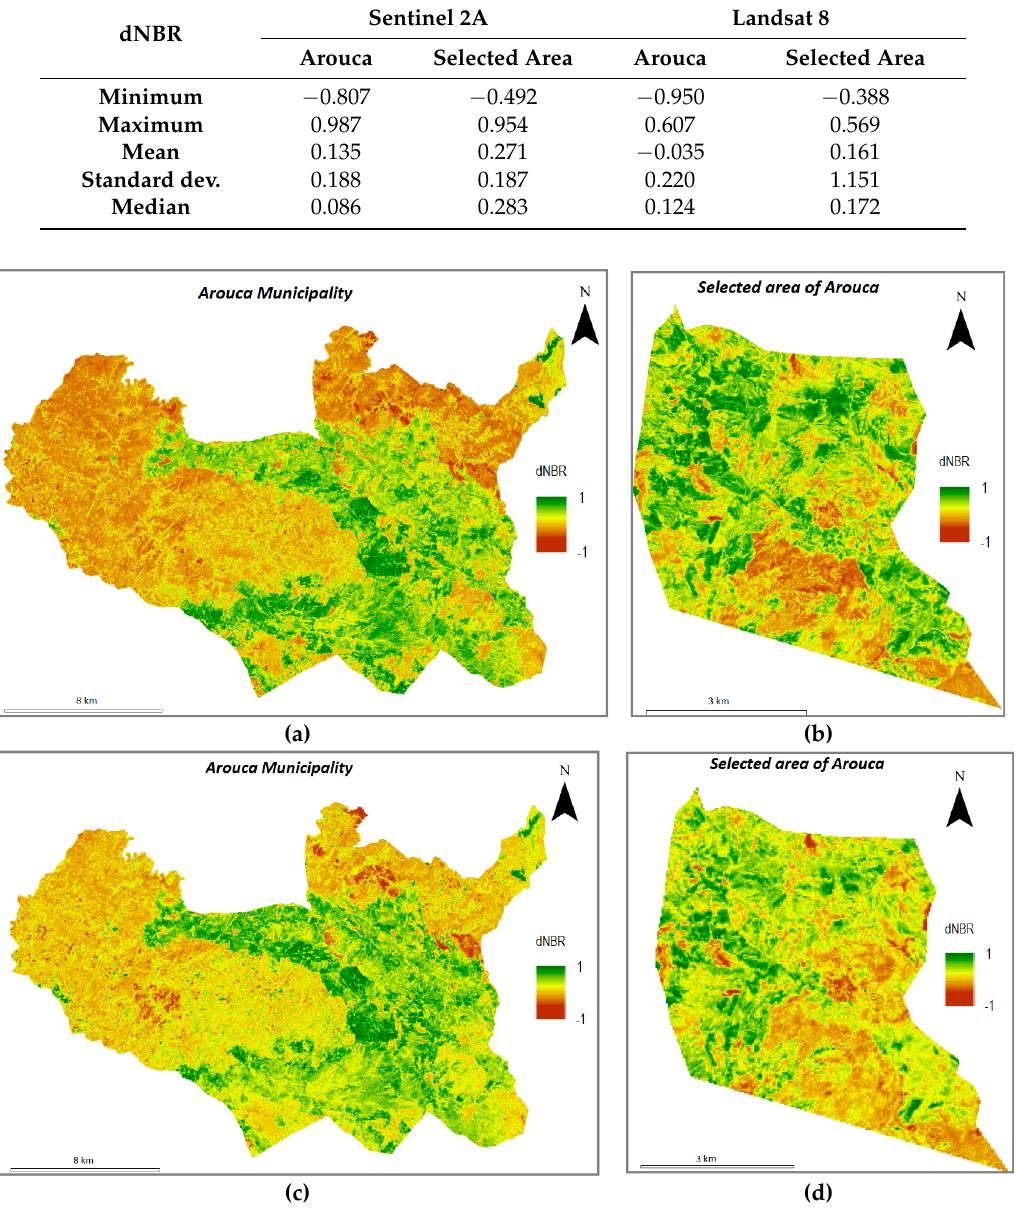
Figure 9. dNBR for: ( a ) Arouca municipality and ( b ) selected area calculated from Sentinel 2A data; and ( c ) Arouca municipality and ( d ) selected area calculated from Landsat 8 data.